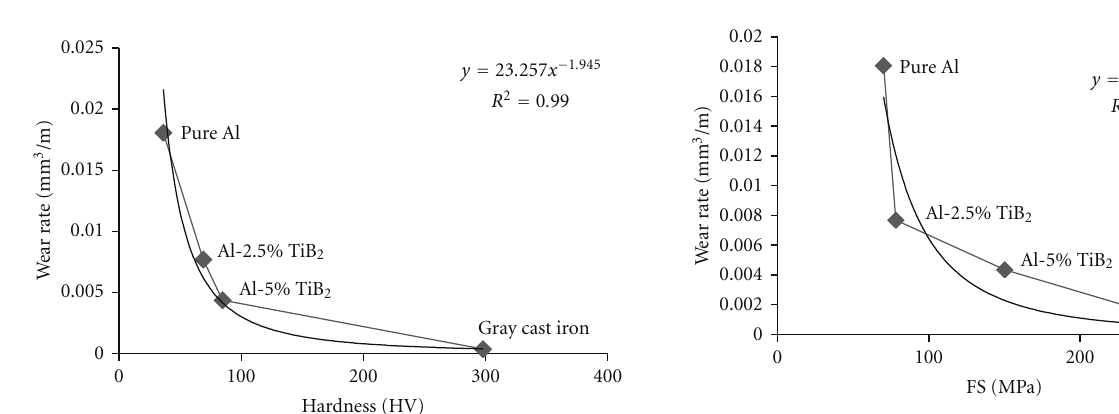
Figure 12: E ff ect of hardness on wear rates of composites.